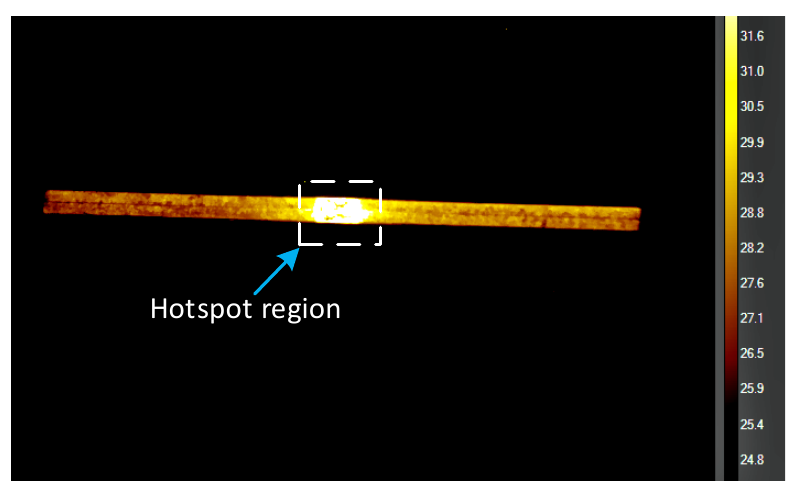
Figure 7. Surface temperature distribution from infrared camera at 8 s. Table 3. Estimated parameters of the fault region obtained from the Lsqnonlin